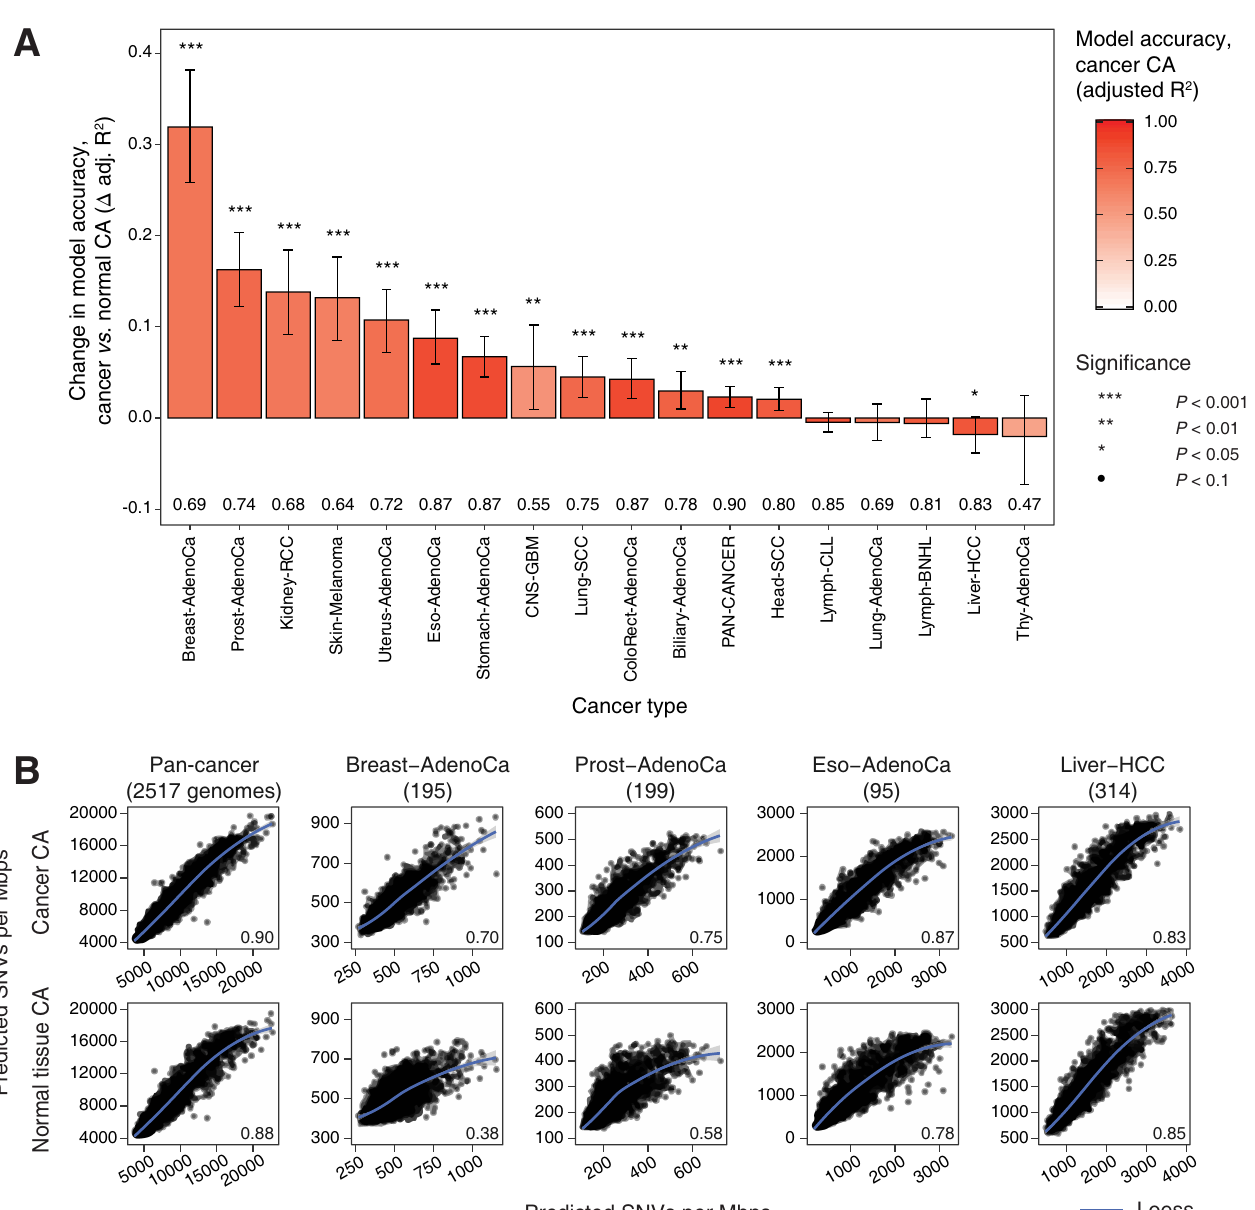
PLOS Computational Biology | https://doi.org/10.1371/journal.pcbi.1010393 August 10,